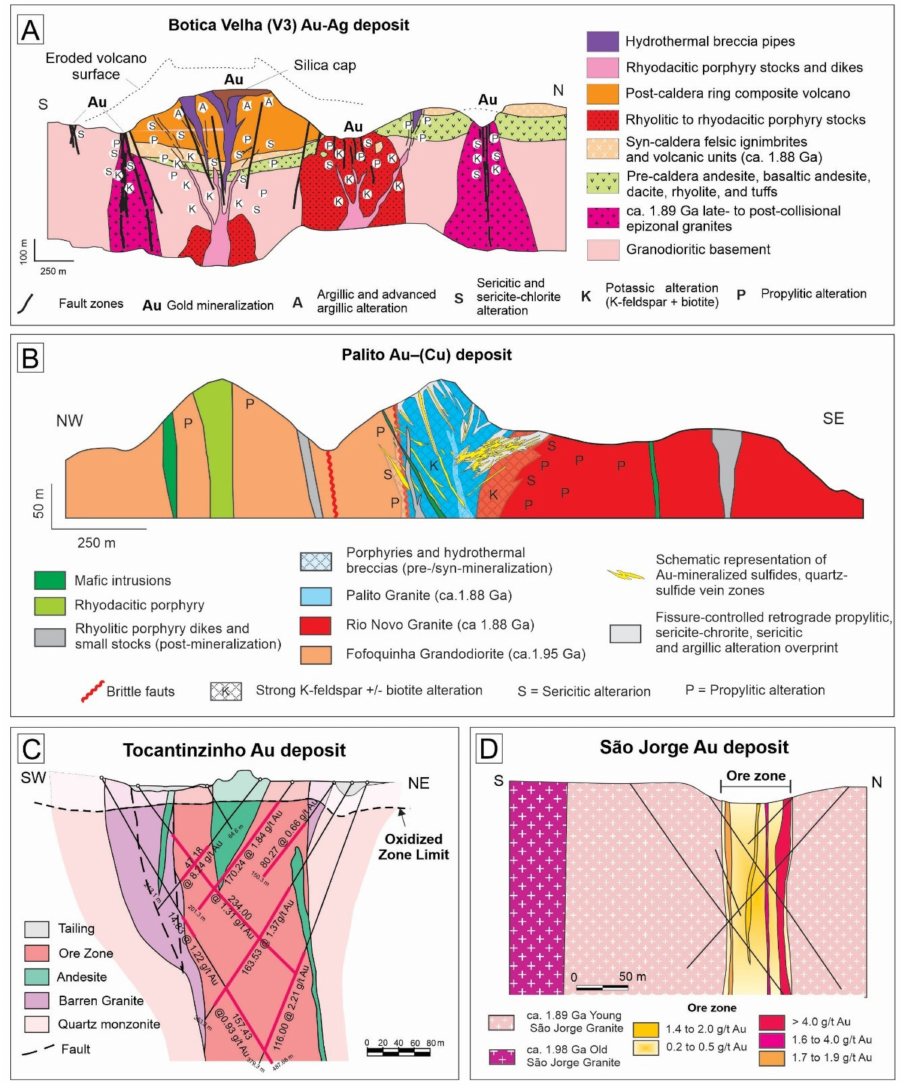
Figure 3. Cross-sections of the gold-(polymetallic) deposits of the Tapaj ó s Mineral Province. ( A ) Schematic cross-section of the Botica Velha (V3) high-sulfidation gold–silver epithermal deposit [15] (#1 in Figure 2); ( B ) Schematic cross-section of the Palito gold–(copper) porphyry deposit (#5 in Figure 2). The scale of de gold-mineralized veins and associated sericitic alteration are exaggerated to represent the style of structure-controlled mineralization (this study); ( C ) Cross-section of the Tocantinzinho gold porphyry-like deposit [89] (#4 in Figure 2); ( D ) Cross-section of the S ã o Jorge structurally-controlled granite-hosted gold deposit [90] (#7 in Figure